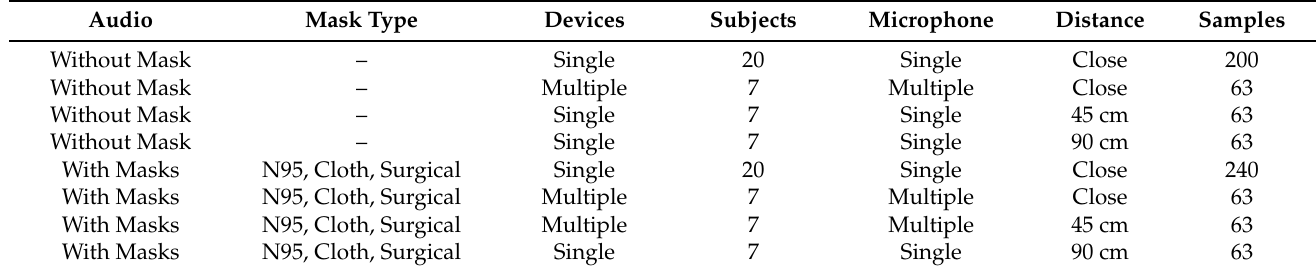
Table 1. Details of the Multi Speaker Face Mask (MSFM)